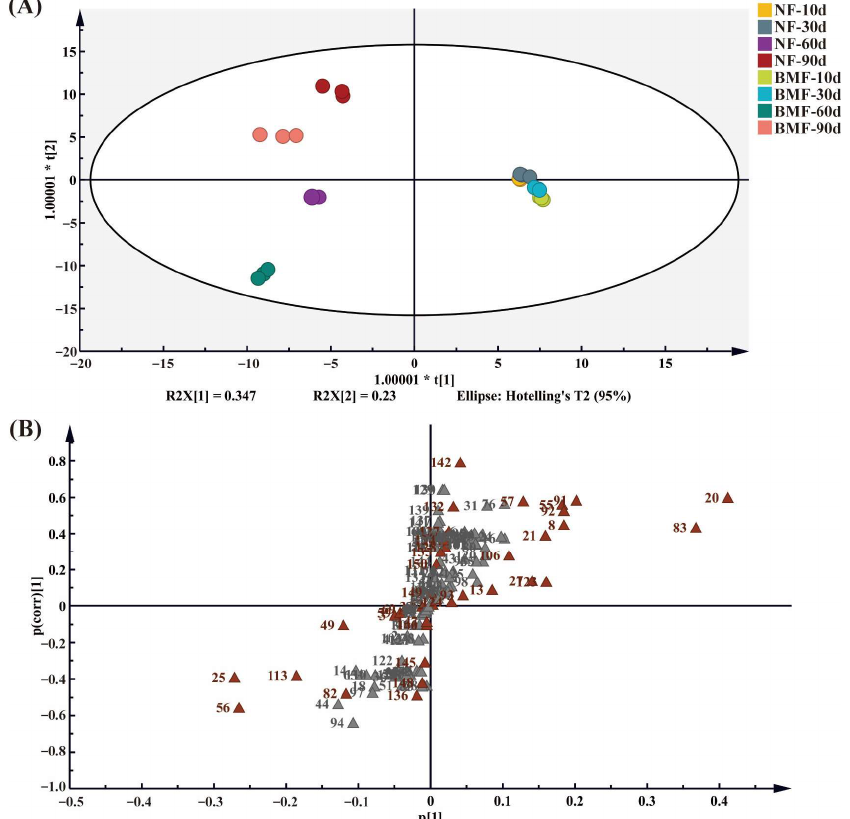
Figure 3. The analysis of dynamics changes of metabolites in NF and BMF during fermentation. ( A ) The OPLS-DA plot based on metabolites, including OAs, FAAs and VCs on days 10, 30, 60, and 90 of fermentation in NF and BMF. ( B ) The S-plot based on the metabolites in NF and BMF.